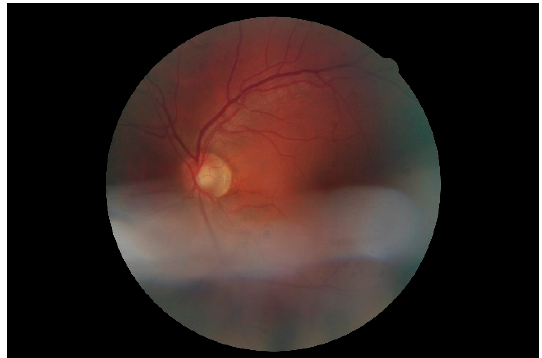
Figure 7. Process of retinal vessel segmentation using MLP.